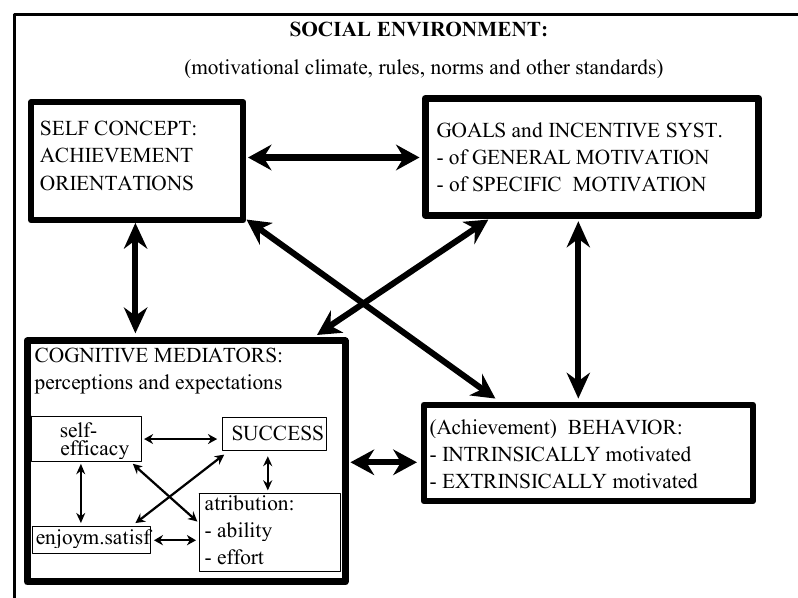
Figure 2. Dynamic interactive model of sport motivation.